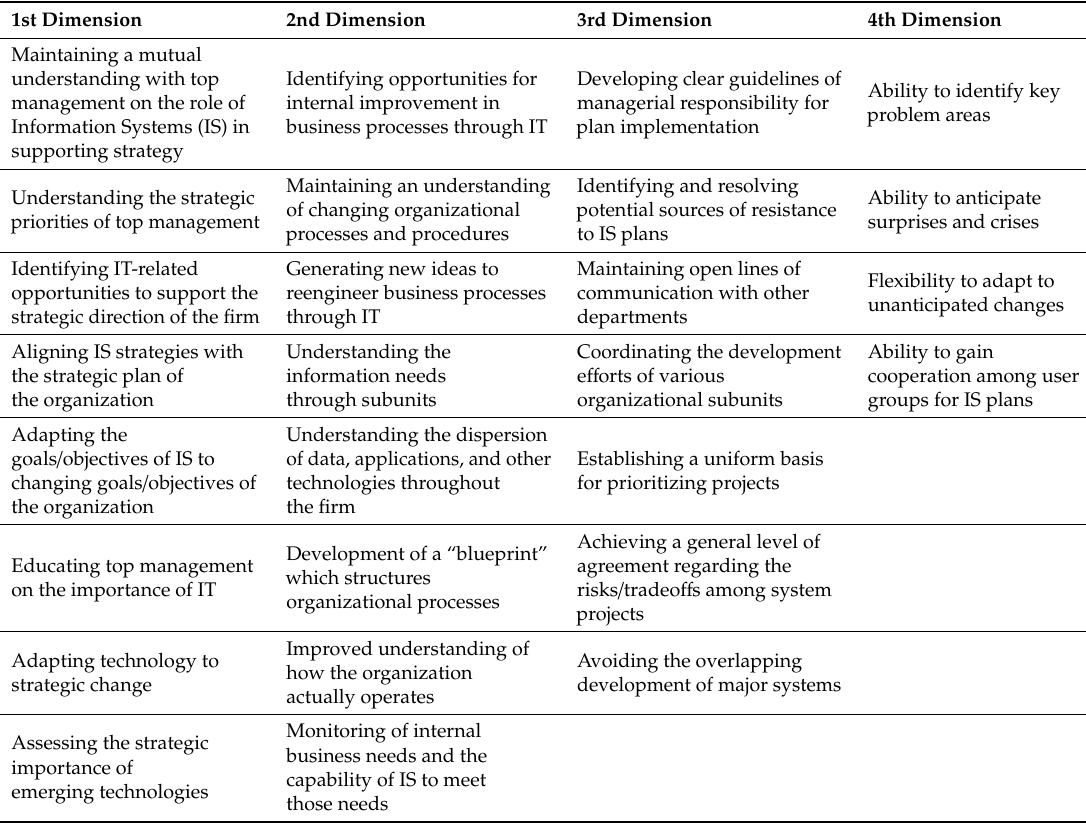
Table 2. Success dimensions and